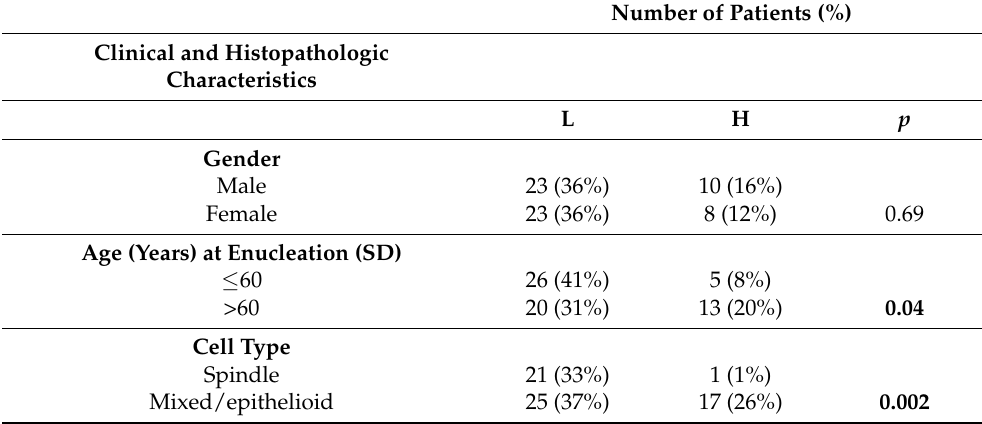
Figure 1. LAG3 expression in UM. The LAG3 expression level of 64 UM as seen in an Illumina array was sorted from low to high; we selected the inflection point of 6.87 to divide the cases into a low and high expression group. Table 1. LAG3 expression compared with clinico-pathological and genetic characteristics in a set of 64 UM. Groups were separated according to the inflection point of 6.87; L: low expression, H: high expression. Using Pearson’s Chi-square test, p ≤ 0.05 is considered significant. Significant p values are indicated in bold. Numbers in brackets represent percentages.